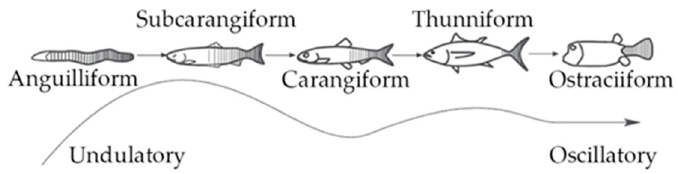
Figure 1. Body and caudal fin (BCF) swimming mode classifications [3].